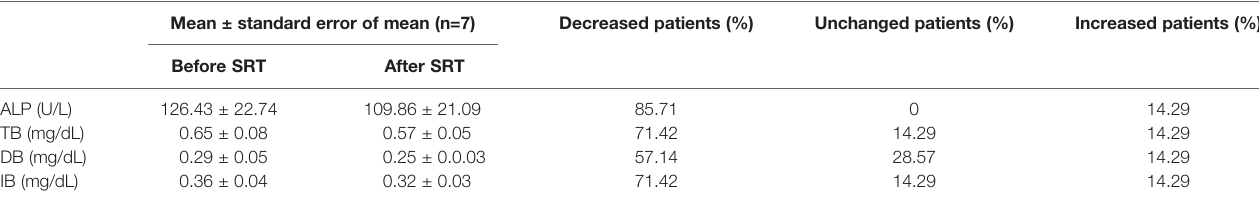
TABLE 2 | Decreased levels of ALP and bilirubin in PBC serum after full-mouth scaling and root planing. Mean ± standard error of mean (n=7) Decreased patients (%) Unchanged patients (%) Increased patients